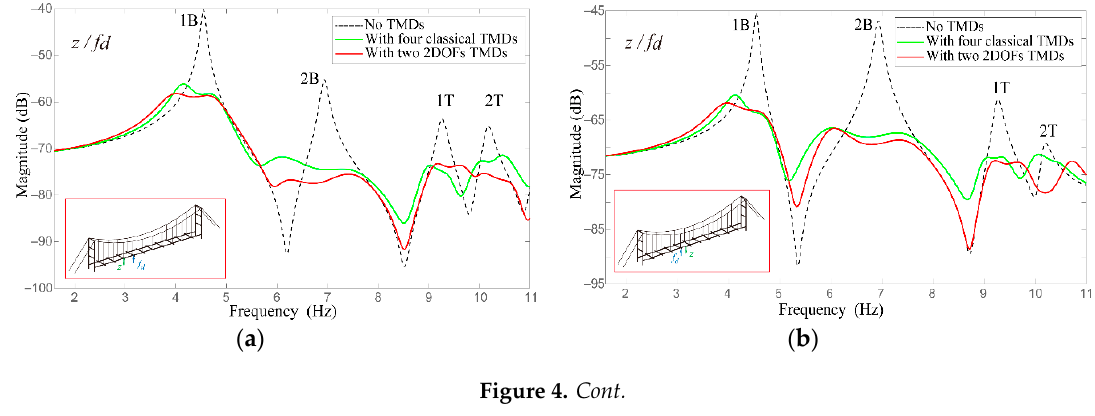
Figure 3. Numerical results: FRFs of the deck without and with the TMDs. The TMDs are targeted for the damping of the mode pair (2B,1T) and